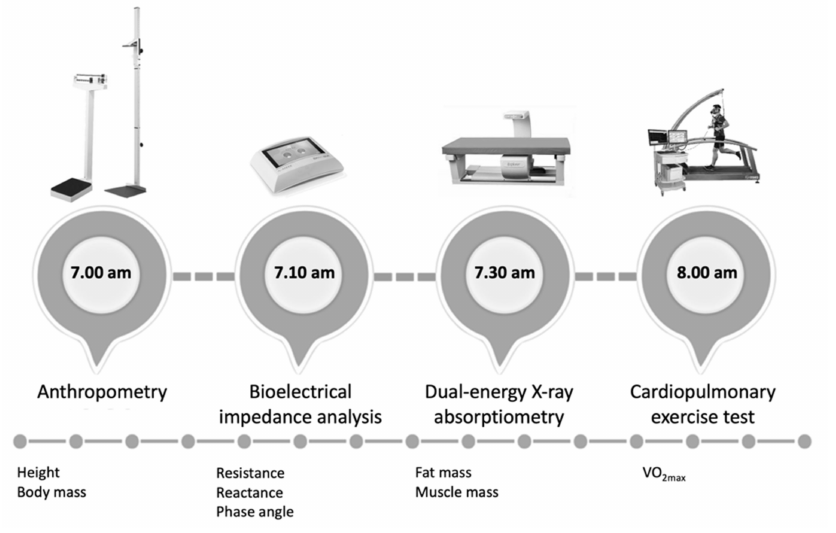
Figure 1. Timeline of stations performed by the futsal players involved in the